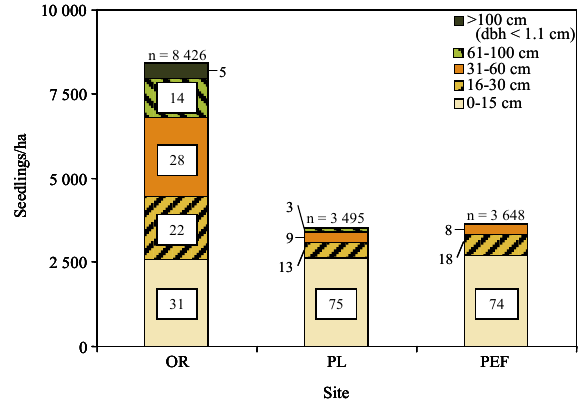
Figure 3. Height distribution of northern white-cedar regeneration on three sites selected throughout the native range of northern white-cedar: Outaouais Region (OR), with no deer or evidence of browsing, Papineau-Labelle wildlife reserve (PL), with high deer density and browsing, and Penobscot Experimental Forest (PEF), with the highest deer density and most intense browsing. Numbers indicate the percentage of seedlings by height class; n = total number of seedlings